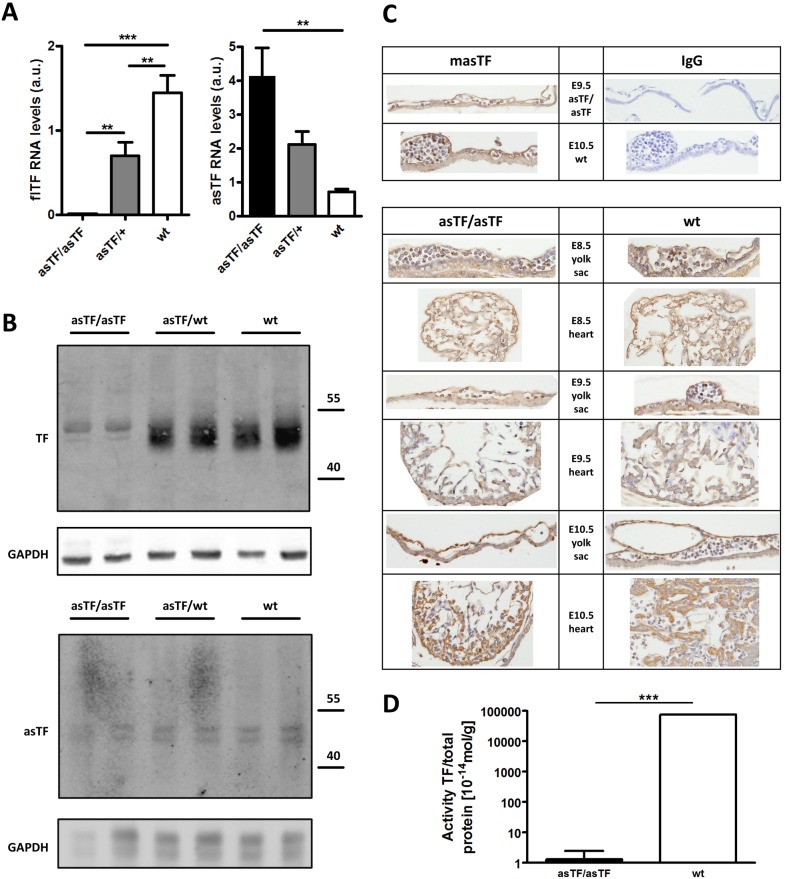
Expression and activity of asTF.(A) RNA levels of asTF and flTF were measured in E9.5 whole embryos and normalized to S18 expression, N = 5–7, ***P<0.001, **P<0.01 (B) Protein expression of total TF (western blot probed with a rabbit anti-mouse TF polyclonal antibody), asTF (western blot probed with a rabbit anti-mouse asTF polyclonal antibody), and GAPDH in E9.5 whole embryos. Intensity of normalized total TF staining relative to wt (100%) was 74% in asTFKI/wtTF embryos and 19% in asTFKI/asTFKI embryos. Expression of asTF was comparable between homozygous asTFKI, heterozygous asTFKI/wtTF and wt embryos (C) Mouse asTF and rabbit IgG control immunohistochemistry on E9.5 homozygous asTFKI and E10.5 wt yolk sac. Mouse asTF immunohistochemistry on E8.5 to E10.5 extraembryonic (yolk sac) and embryonic (heart) tissue of homozygous asTFKI and wt embryos. (D) TF activity of whole embryo lysates was measured with a plasma clotting assay and normalized to total protein. N = 5, ***P<0.001.